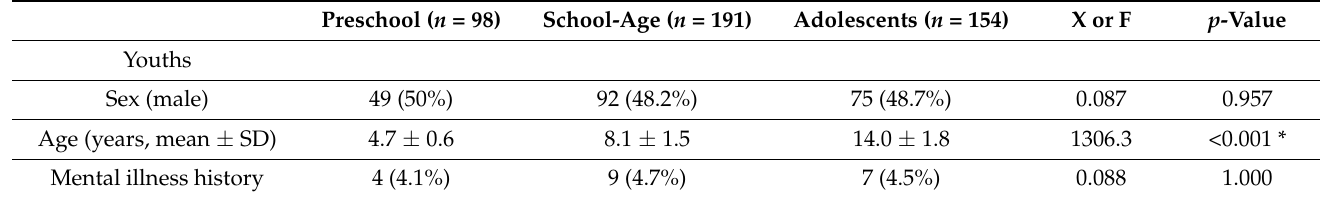
Table 1. Characteristics of preschool, school-aged and adolescents individuals and their